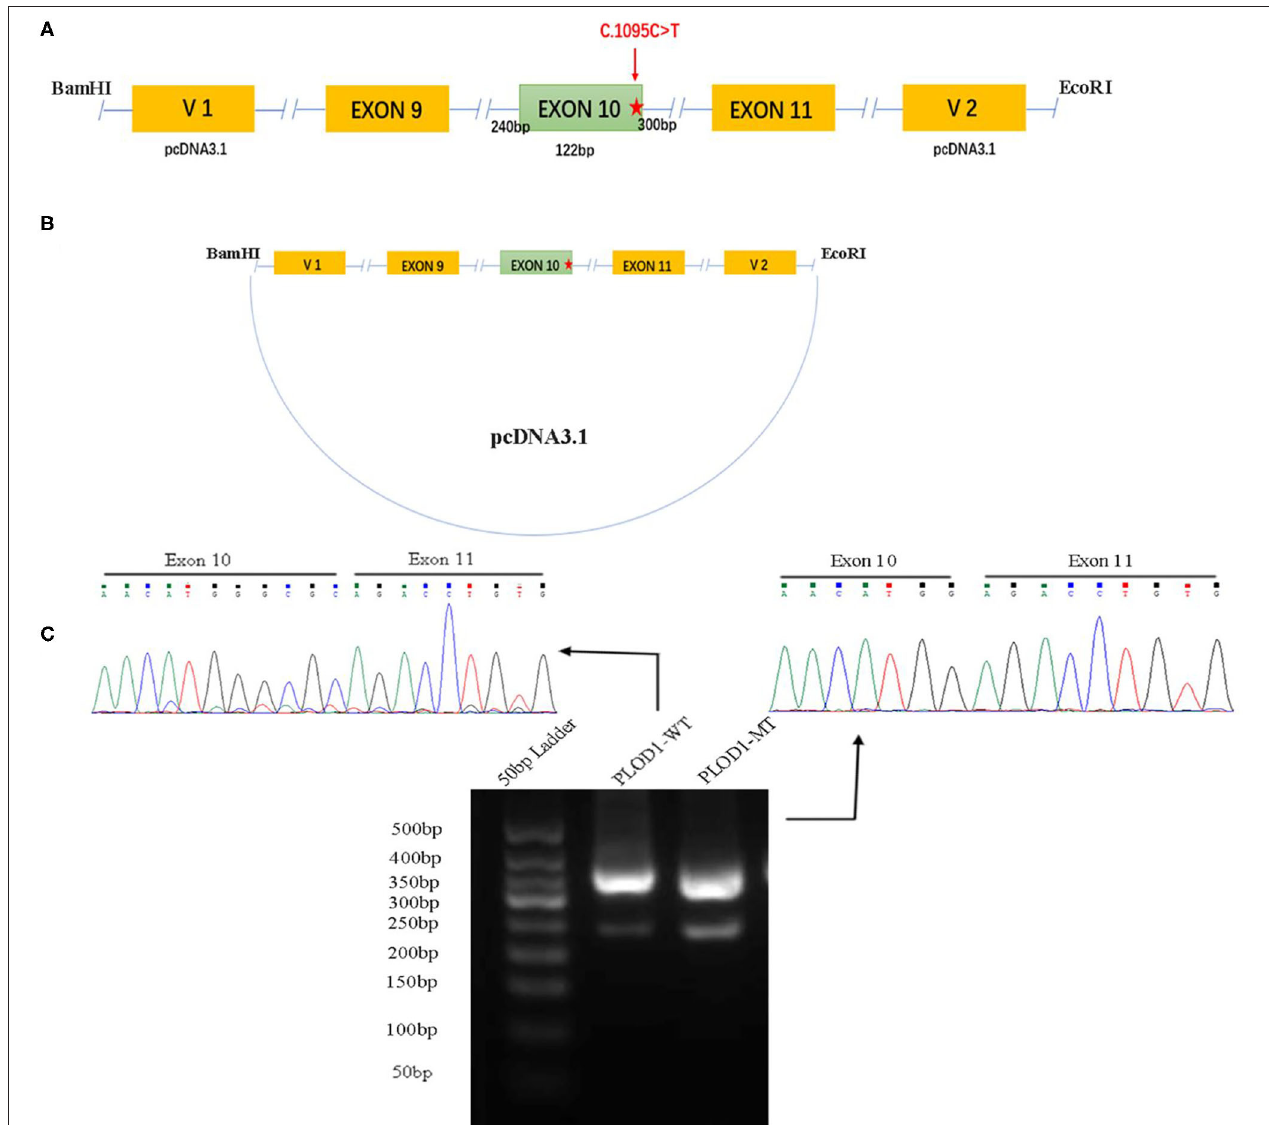
FIGURE 1 | The minigene splicing assay based on the pcDNA3.1 exon trapping vector. (A,B) PLOD1 -WT and PLOD1 -MT plasmids containing exon 9–11 and flanking introns were separately cloned into the Bam HI and Eco RI cloning sites of the pcDNA3.1 vector (the red star, c.1095C > T). (C) Agarose gel electrophoresis of RT-PCR products. The electrophoresis results showed that the band of PLOD1 -MT was lower than that of PLOD1 -WT. The results of RT-PCR amplification of cDNA sequences generated by transfected 293T cells showed that c.1095C > T led to premature termination codon of exon 10 and affected the expression of the four bases